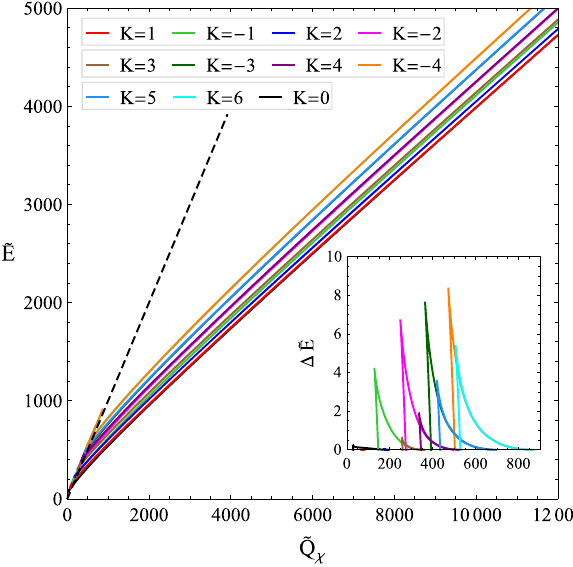
Fig. 12 Dependence of the energy ˜ E of the vortex-Q-ball system on the Noether charge ˜ Q χ for the first few azimuthally excited states. The straight dashed line corresponds to the linear dependence ˜ E = ˜ Q χ . The subplot presents the dependence of the difference Δ ˜ E = ˜ E − ˜ Q χ − ˜ E v on ˜ Q χ in neighbourhoods of cuspidal